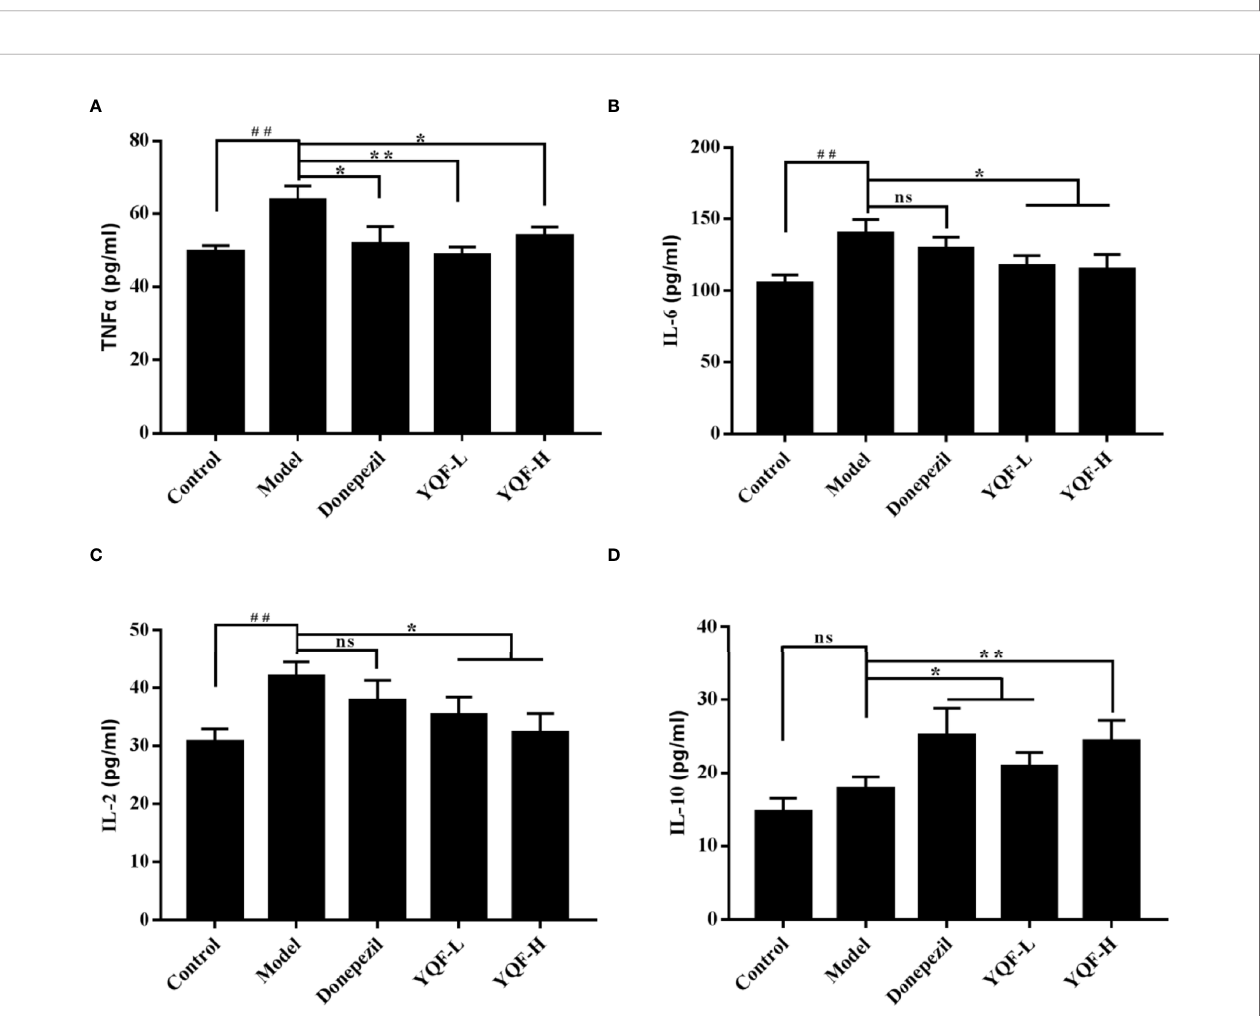
FIGURE 5 | Effects of YQF extract on TNF a , IL-2, IL-6, and IL-10 levels in serum. (A) TNF a level in aged rats. (B) IL-2 level in aged rats. (C) IL-6 level in aged rats. (D) IL-10 level in aged rats. The data are expressed as mean ± SEM, n = 10. ## p < 0.01, compared with control group; * p < 0.05, ** p < 0.01, compared with Model group. ns, no signi fi cant